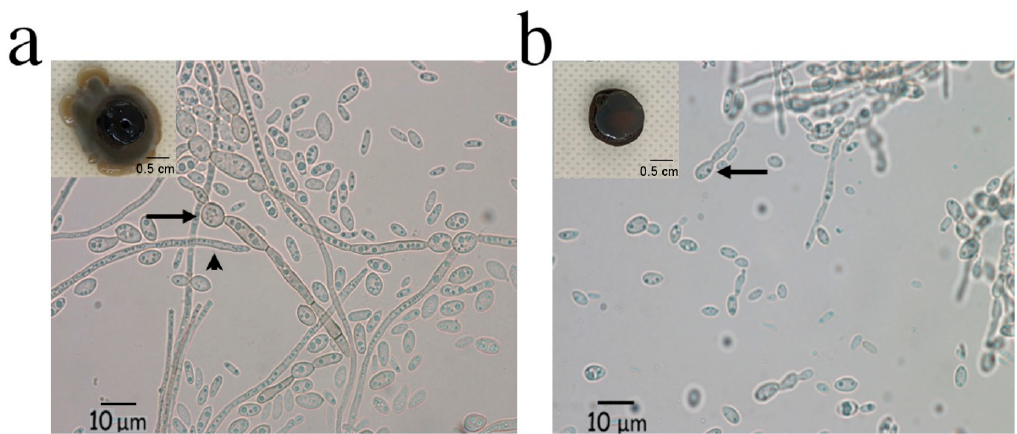
Figure 4. Macroscopic and microscopic morphological changes of strain BMH1013 induced by NaCl. The inner panels in ( a ) and ( b ) show the macroscopic view of the strains, in ( a ) cultures without NaCl; and ( b ) cultures with 0.5 M NaCl. The arrows show the change in the morphology of the conidiophore, while the arrowhead show the hyphae morphology.